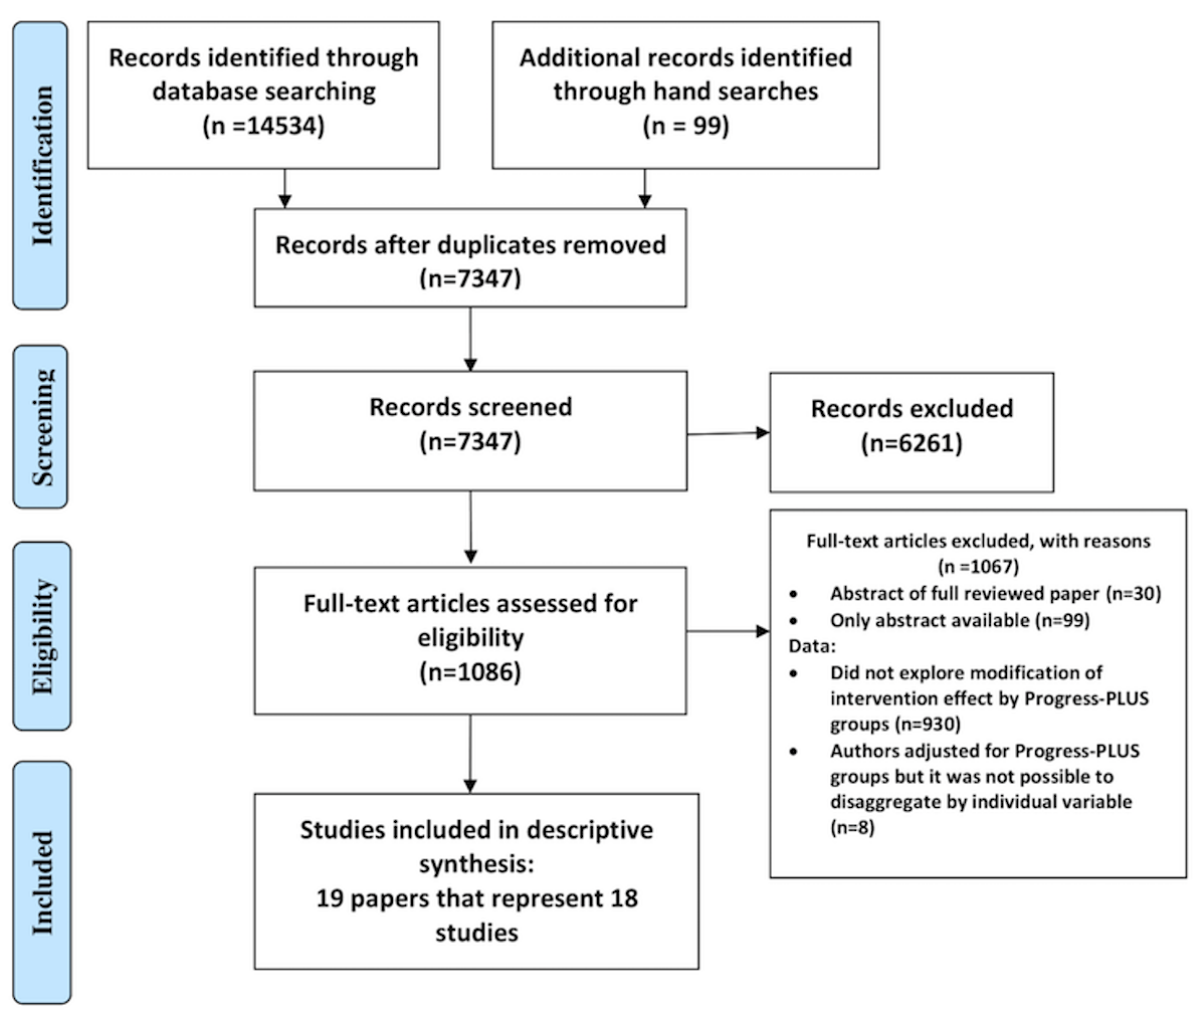
Figure 1. Preferred Reporting Items for Systematic Reviews and Meta-Analysis flow